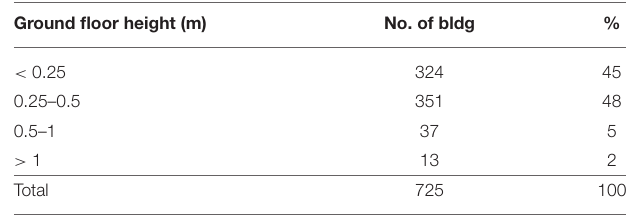
TABLE 3 | Surveyed buildings in different ground floor height